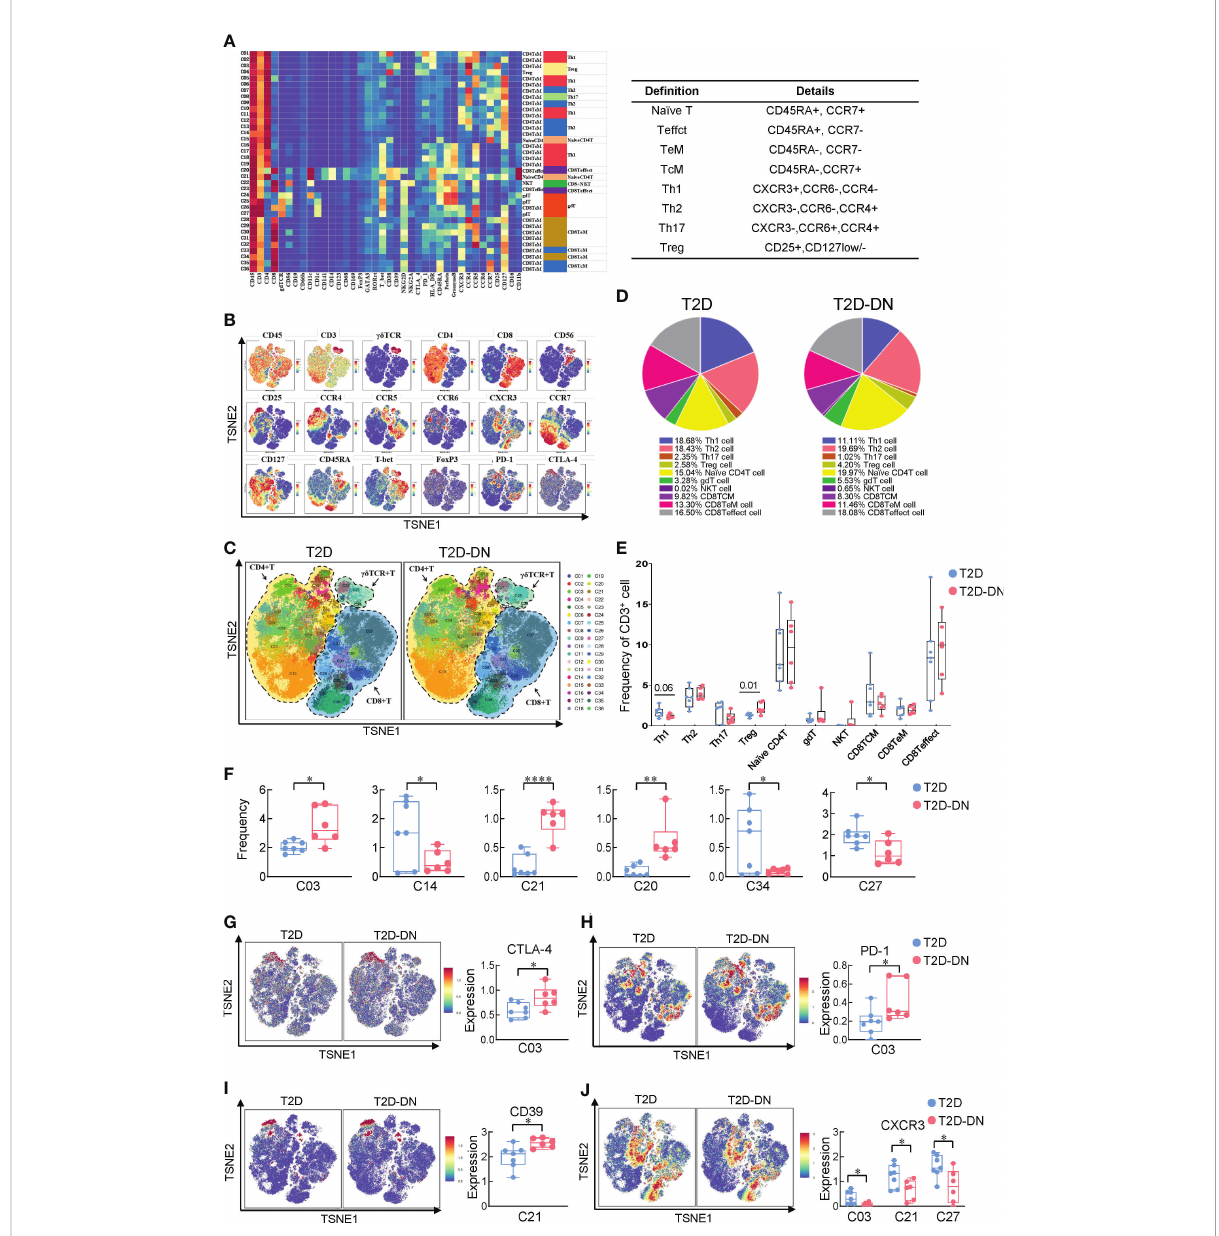
FIGURE 2 Identi fi cation of immune heterogeneity of T cell subsets. (A) Heatmap exhibiting the expressions of 38 immune cell markers in the T cell subsets (left) and 8 marked de fi nitions of T cell subsets (right). (B) Distributions of functional traits are expressed in the different T cell subsets. (C) Island maps exhibit the measurable T cell subsets distribution. (D) Pie chart characterizing the differences of primary T cell subsets proportions between T2D-DN and T2D patients. (E) Statistical frequency differences of T cell subsets between T2D-DN and T2D patients. (F) Signi fi cantly changed T cell subsets between T2D-DN and T2D patients. (G) CTLA-4, (H) PD-1, (I) CD39, and (J) CXCR3 in the speci fi c T cell subsets between T2D-DN and T2D patients. Data are expressed as means ± SEM, n = 6 in T2D-DN group and n = 7 in T2D group., * P < 0.05, ** P < 0.01, **** P < 0.0001 vs. T2D